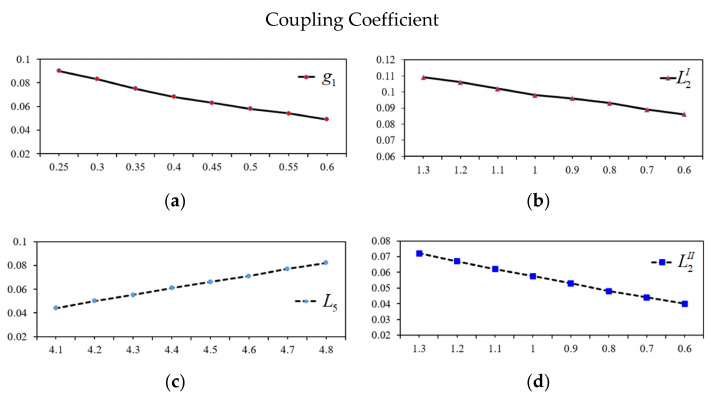
Figure 5. Coupling coefficient with variation of g 1 , L 5 ( L 6 = 7.45 mm), L 2 I , and L 2 I I . ( a ) Distance gap g 1 (mm). ( b ) The length of L 2 I (mm). ( c ) The length of L 5 (mm). ( d ) The length of L 2 II